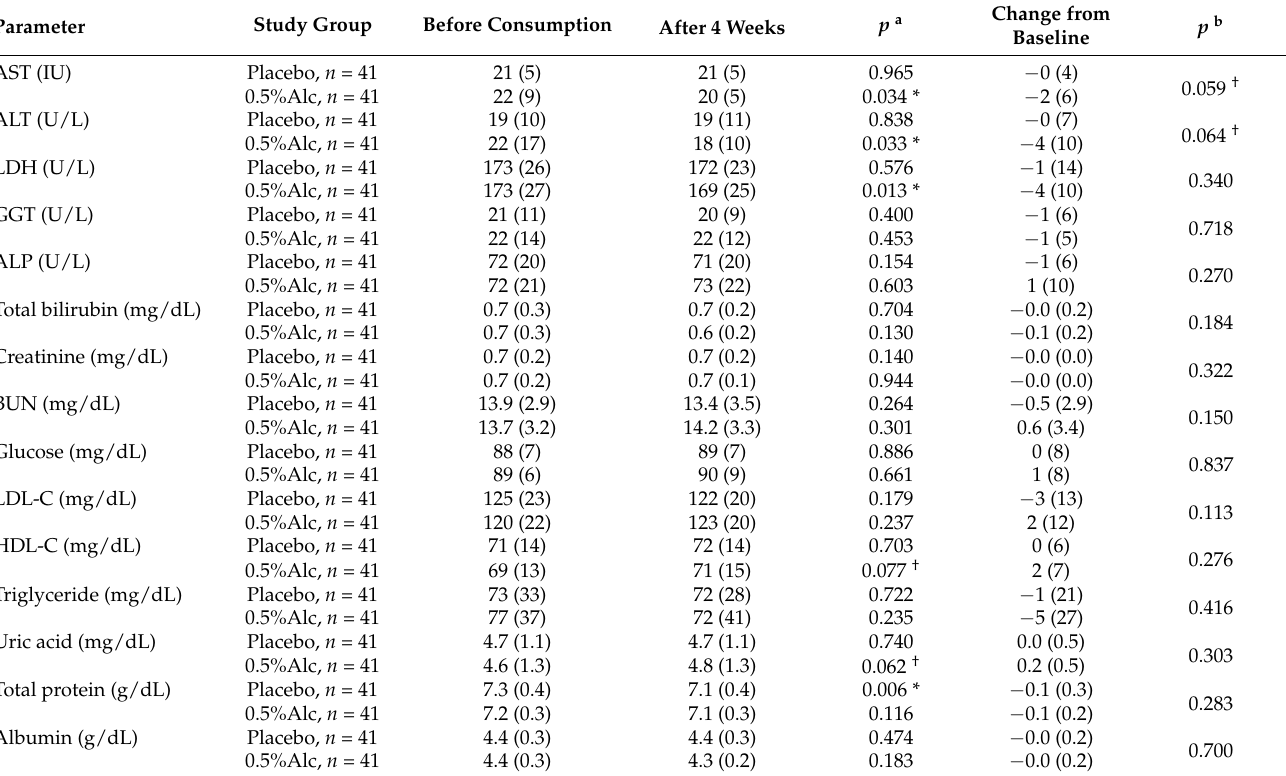
Table 2. Changes in blood parameter concentrations during the crossover